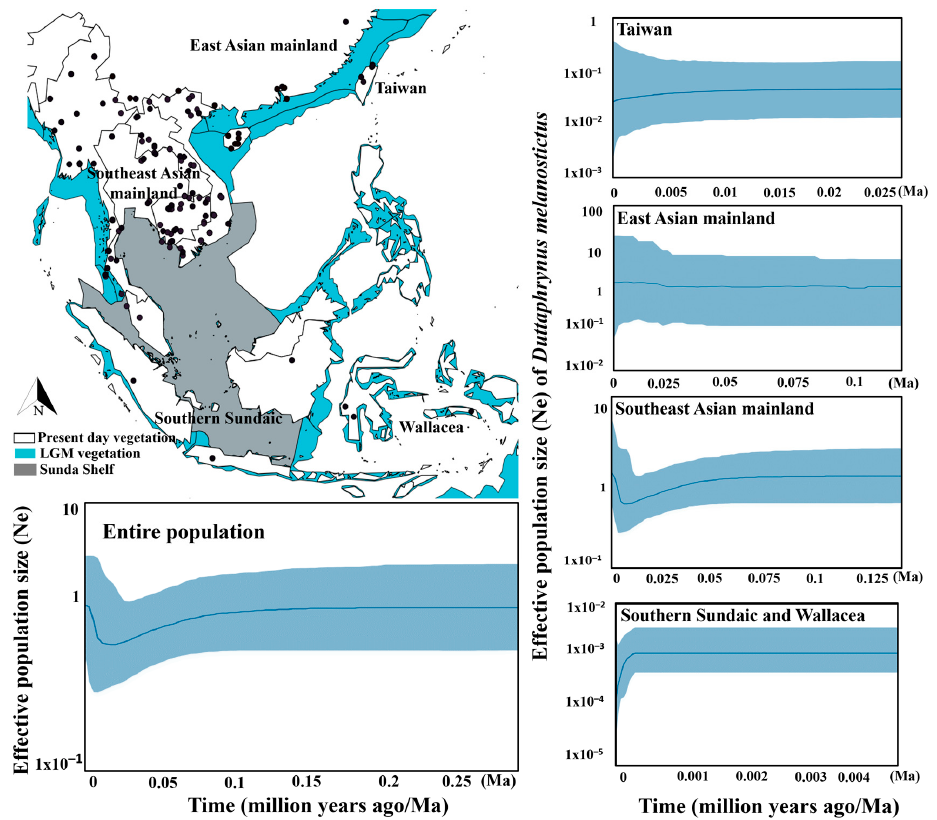
Figure 5. Bayesian Coalescent Skyline Plot analyses for all populations merged and selected population of interest for Duttaphrynus melanostictus. The blue line is the median estimate of the estimated effective population size. The shaded areas represent the 95% interval. The x-axis represents the time in years and y-axis represents the effective population size (Ne). The blue shade on the map indicates vegetation during LGM, with emphasis on Sunda shelf extension. The map was built using QGIS [96], overlaid with the LGM vegetation [97] and Sunda Shelf map [98].